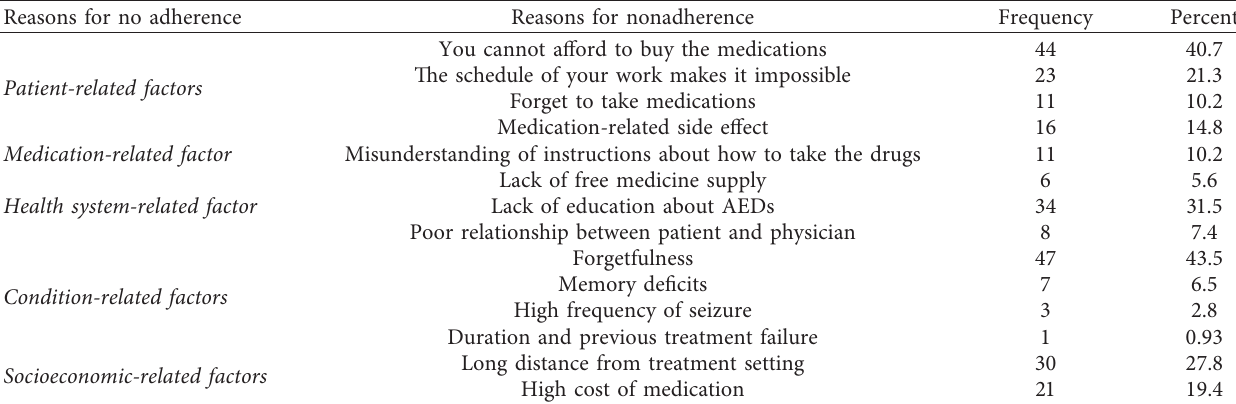
Table 4: Reasons for nonadherence among epileptic patients on AEDs at MTUTH from March 10 to April 10, 2018. Reasons for no